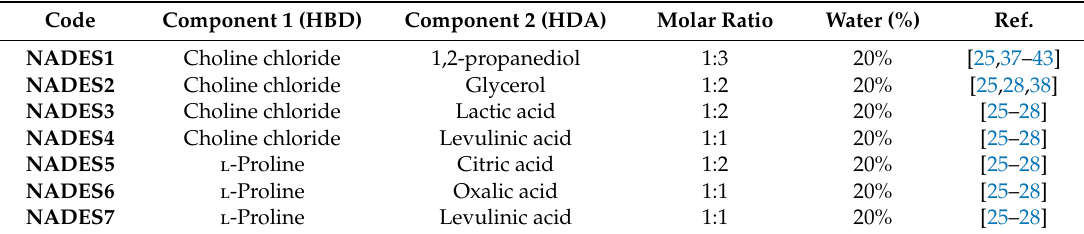
Table 3. Composition of the Natural Deep Eutectic Solvents (NADES) used in the present study.